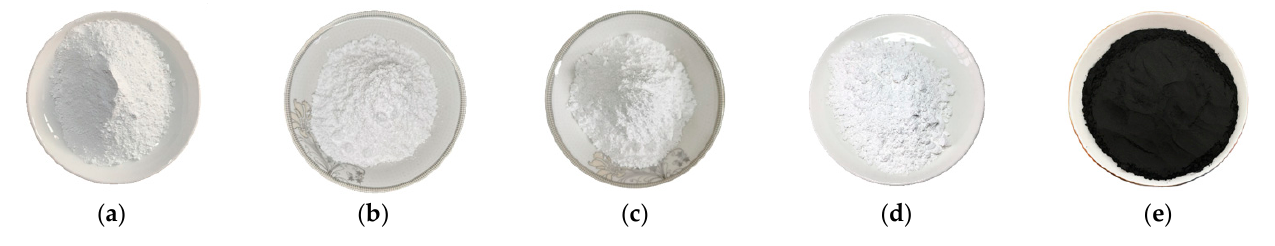
Figure 1. Sample of nano-metallic oxide particles: ( a ) NM; ( b ) NA; ( c ) NR; ( d ) NZ; ( e ) NC. Table 1. Physical properties of cement. Table 3. The physical properties of nano-metallic oxides.